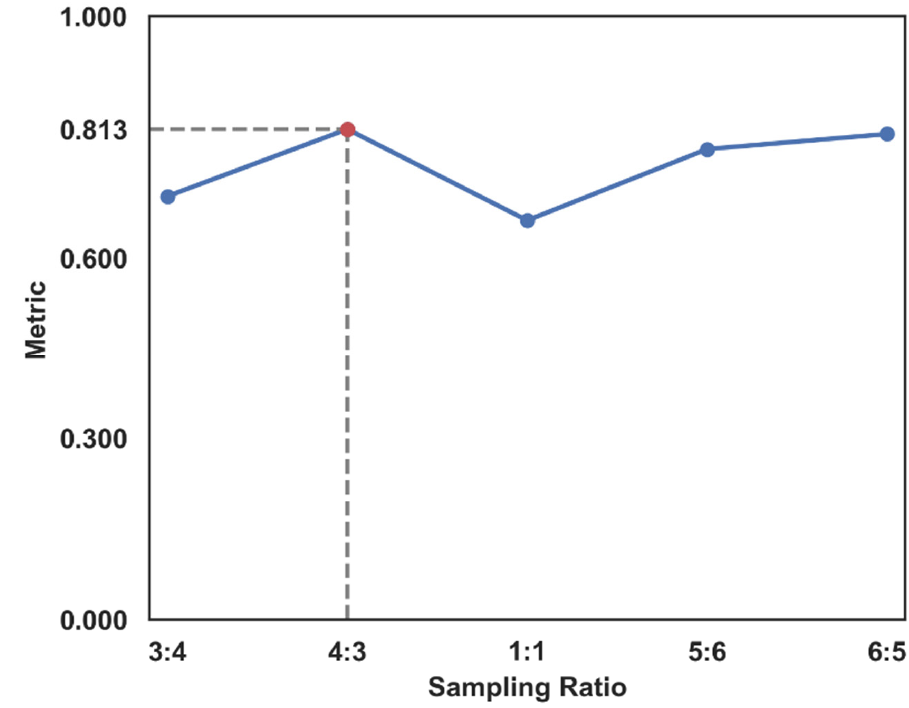
Figure 6. Sampling ratio selection.